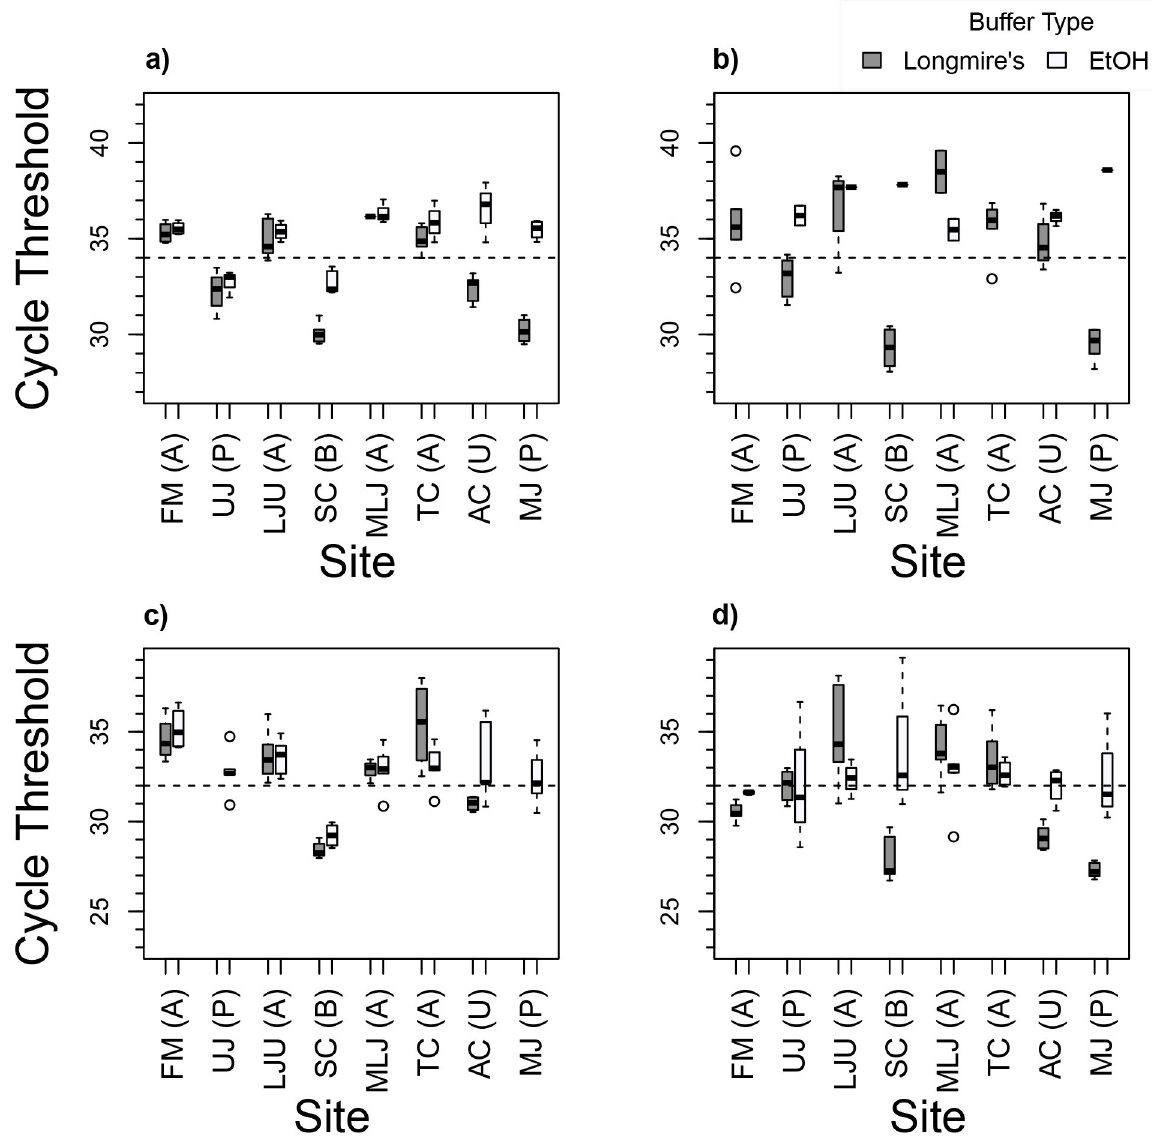
Fig 1. Average cycle threshold values following qPCR amplification with FaRu primers. (A) Sample DNA was extracted with DNeasy and TaqMan chemistry was used, (B) PowerWater TaqMan, (C) DNeasy SYBR, (D) PowerWater SYBR. Cutoff values set at 34 for TaqMan chemistry (A) and (B) and 32 for SYBR (C) and (D). Site codes as in Table 1. Presence is noted as A for putative absence, P for presence, B for both F . rusticus and F . obscurus , and U for unknown.